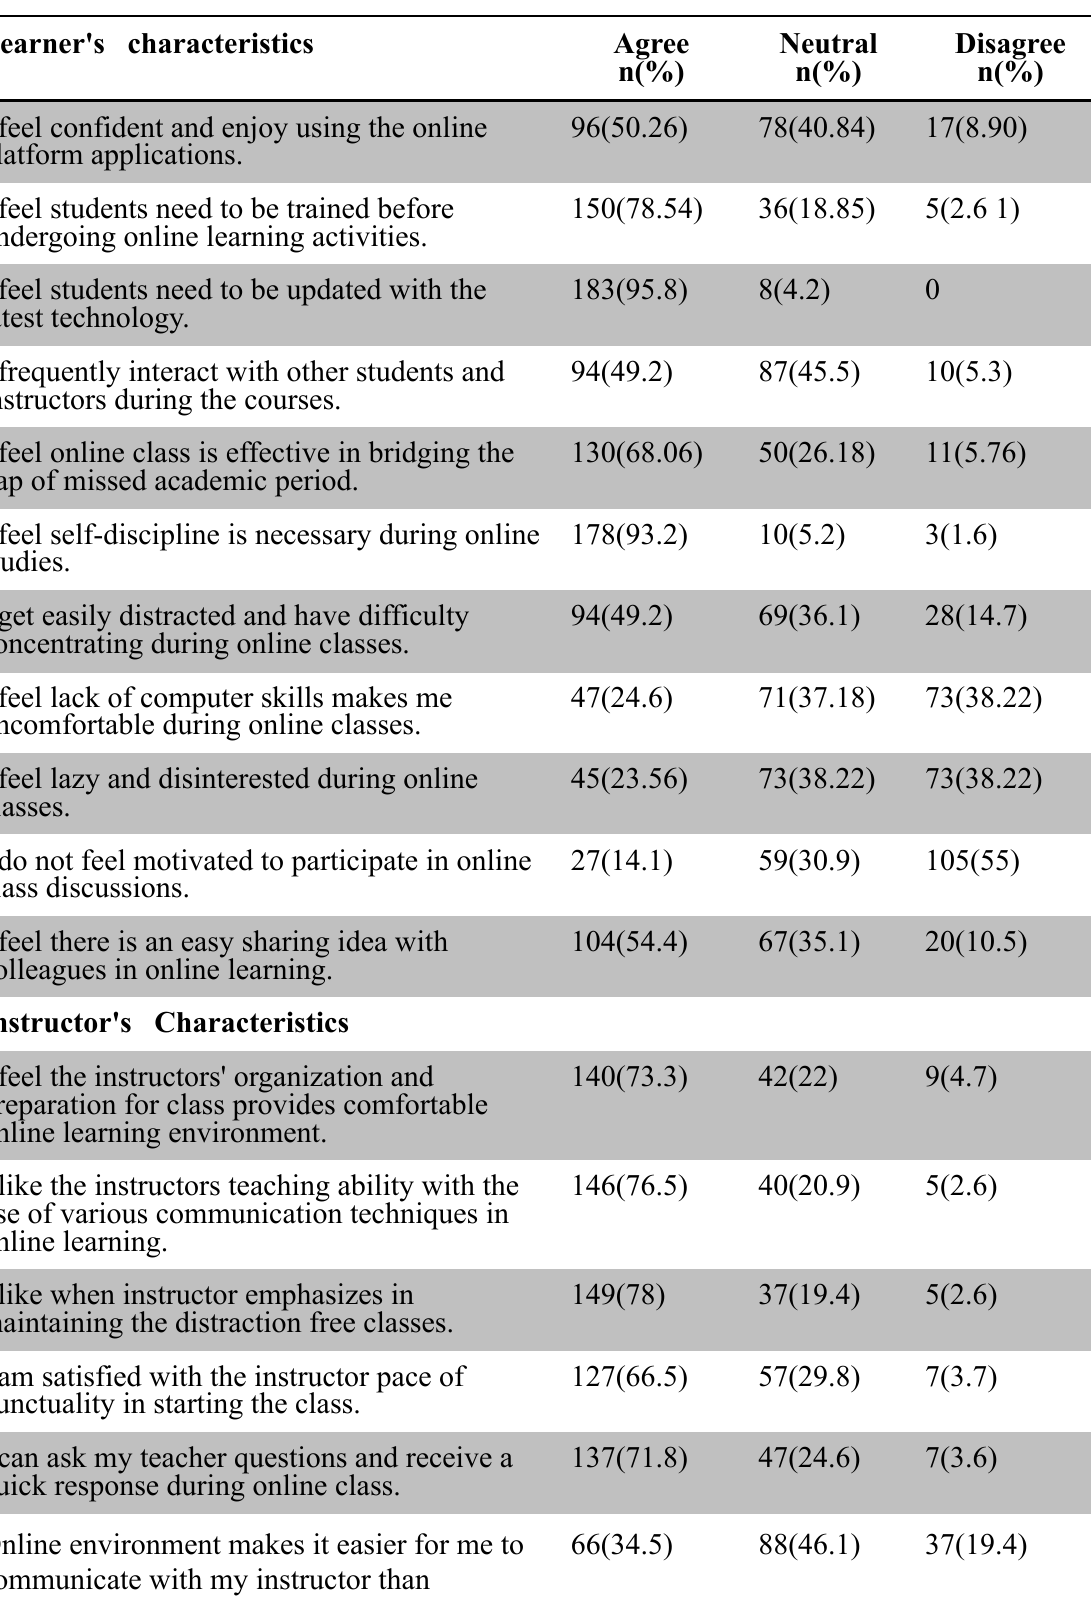
Table 1: Participants' Response regarding Learners and Instructors' Dimension